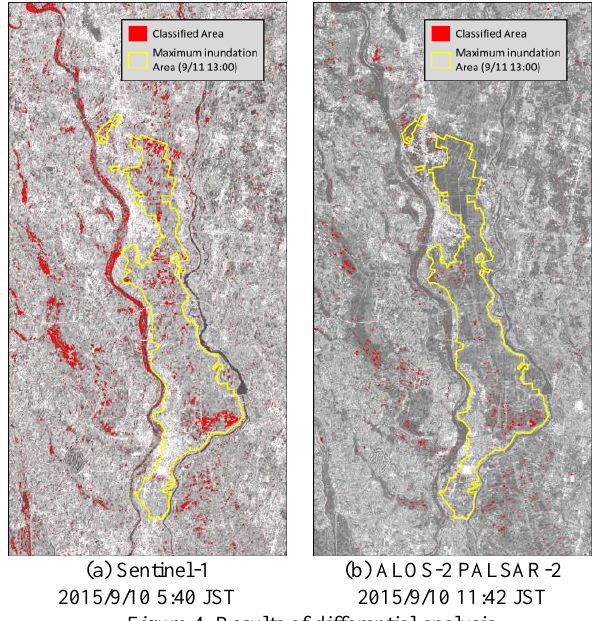
Figure 4. Results of differential